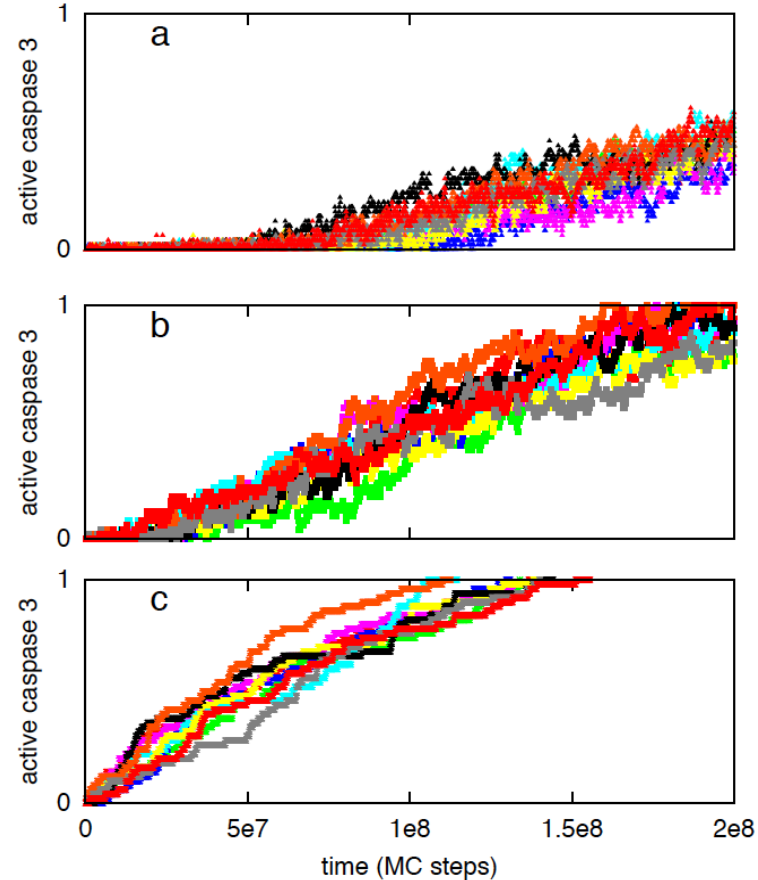
Figure 4. Single cell caspase 3 activation in Bid deficient cells for the following values of XIAP inhibition: XIAP = 60 nM, ( a ), XIAP = 30 nM, ( b ), XIAP = 0 nM ( c ). Smac concentration is kept constant at 50 nM. Data is shown for 10 representative single cells for each XIAP concentrations; each color corresponds to apoptosis activation for a single cell (Monte Carlo run). Decreasing XIAP concentration results in increased type 1